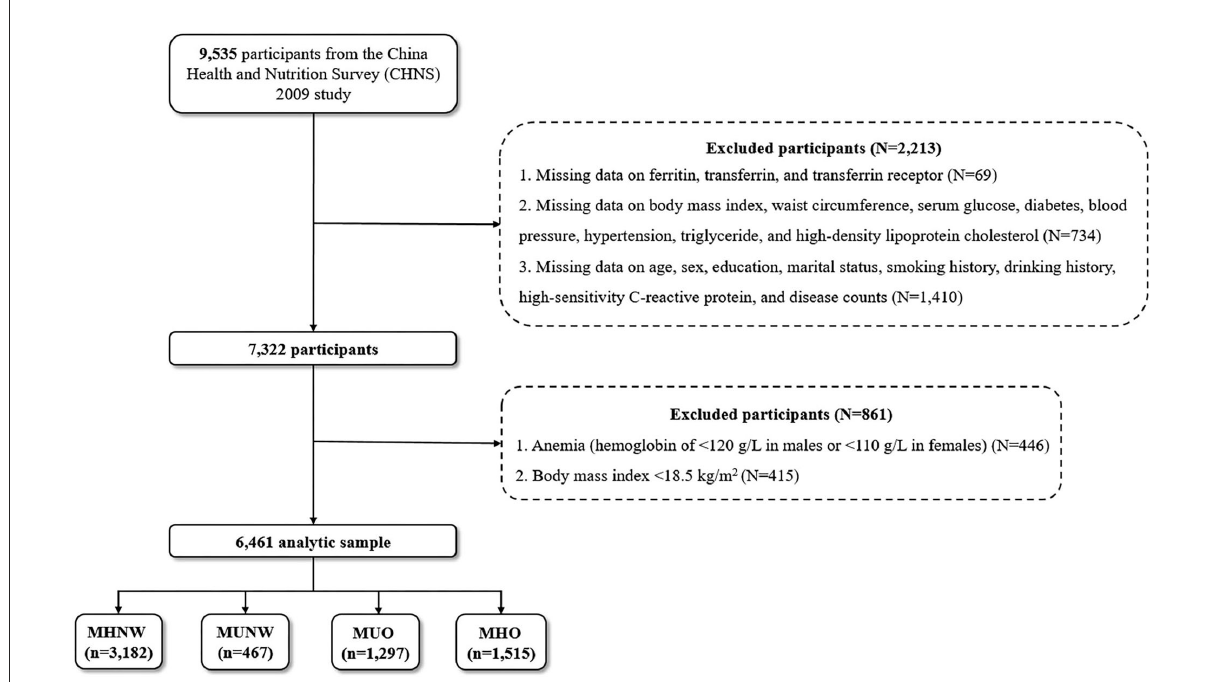
FIGURE1 Flow chart of study participants. MHNW, metabolically healthy with normal weight; MUNW, metabolically unhealthy with normal weight; MUO, metabolically unhealthy with overweight/obesity; MHO, metabolically healthy with